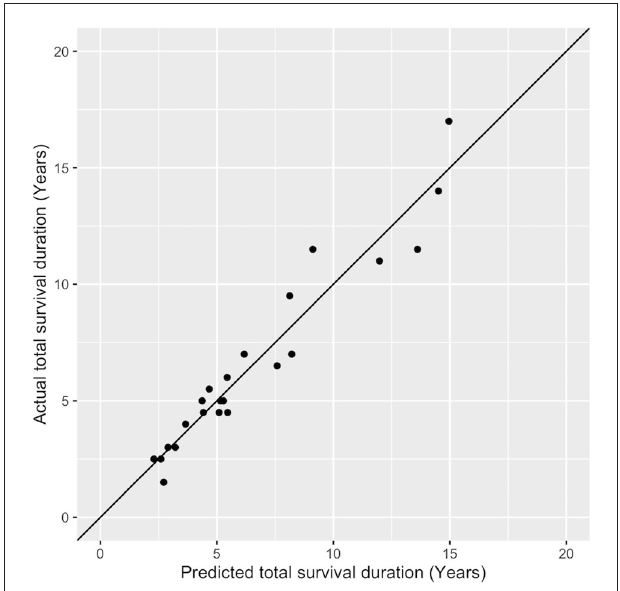
FIGURE 5 | Kaplan-Meier survival curve in patients by sex. There is no difference on median survival age by sex in this cohort. that the UPSPRS score could estimate the probability of the survival (13). Litvan et al. reported that onset of falls during the first year, early dysphagia and incontinence predicted a